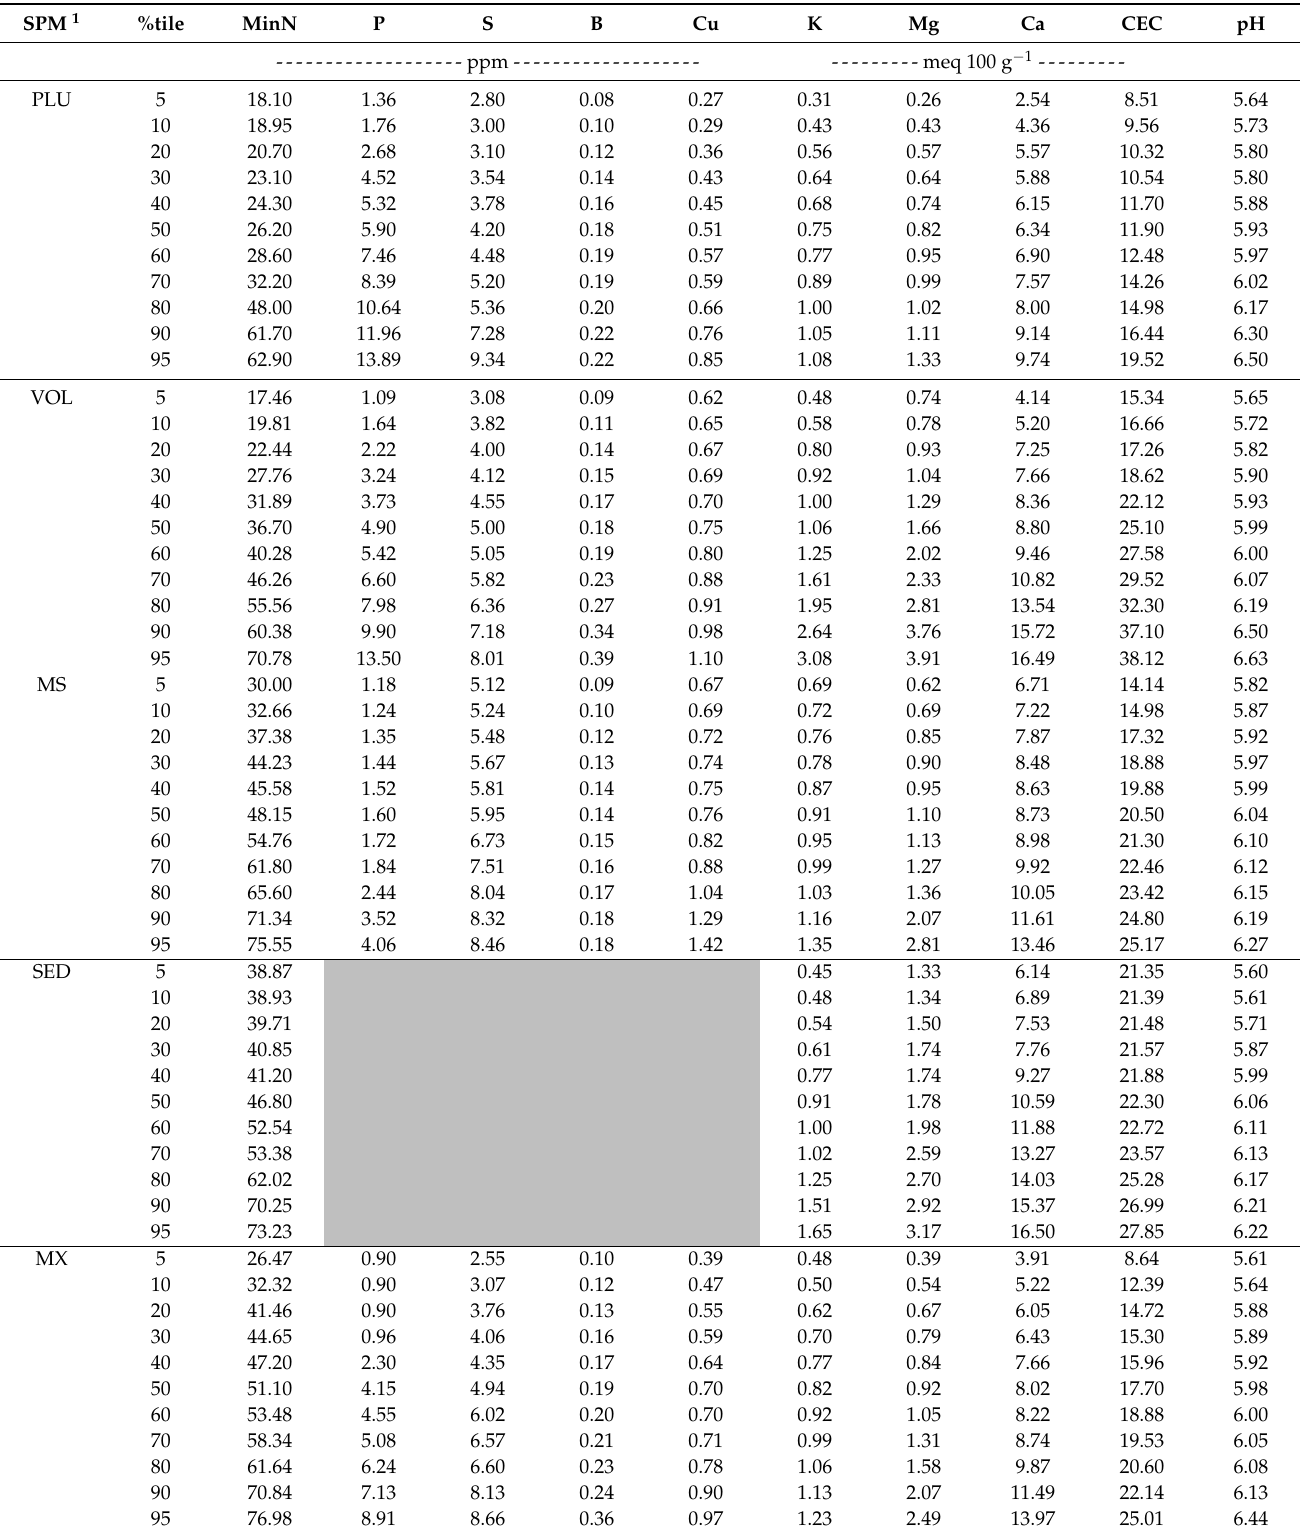
Table 4. Soil chemical characteristic percentiles among sites on different soil parent materials. Gray shaded region reflects inadequate sample size for CDF